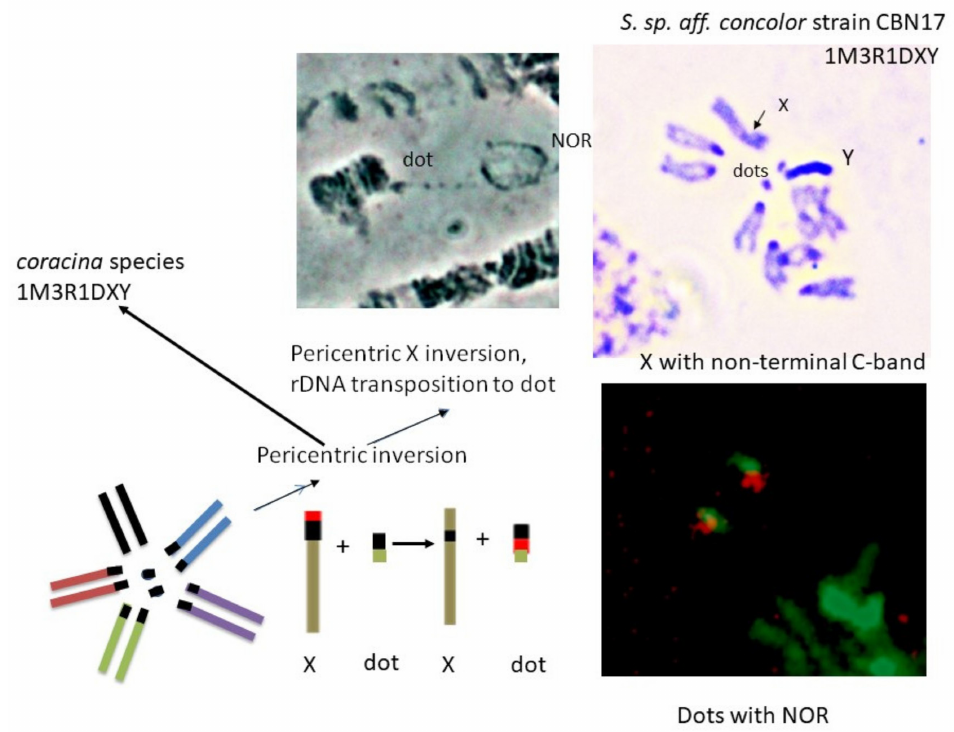
Figure 10. Scheme of changes in an ancestral karyotype that could have resulted in the formation of the S. sp. aff. concolor strain CBN17